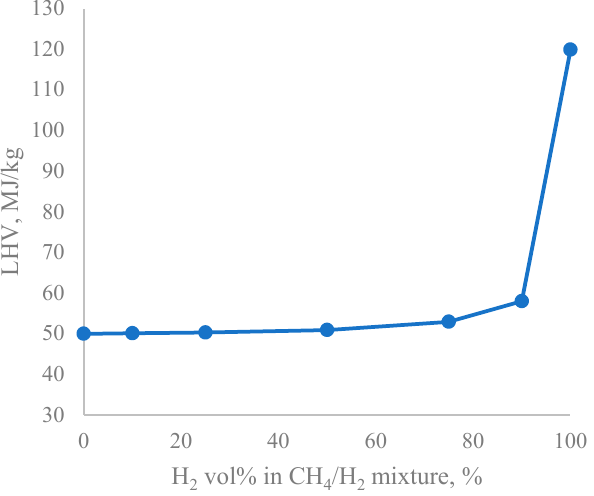
Figure 3. LHV of methane-hydrogen mixtures (Data from references [15,16]).